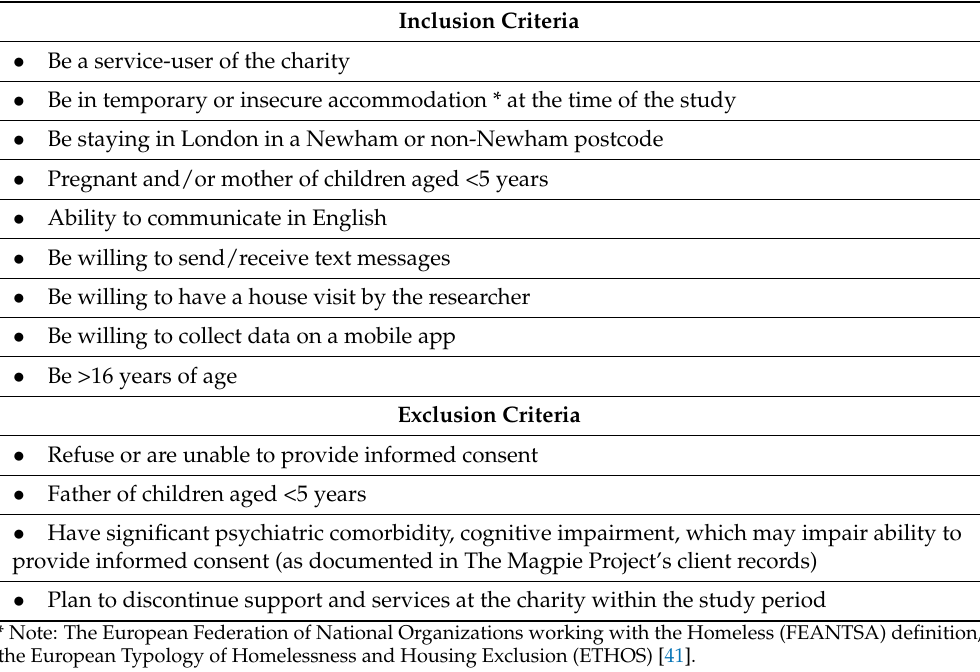
Table 2. Participant criteria for pilot and main